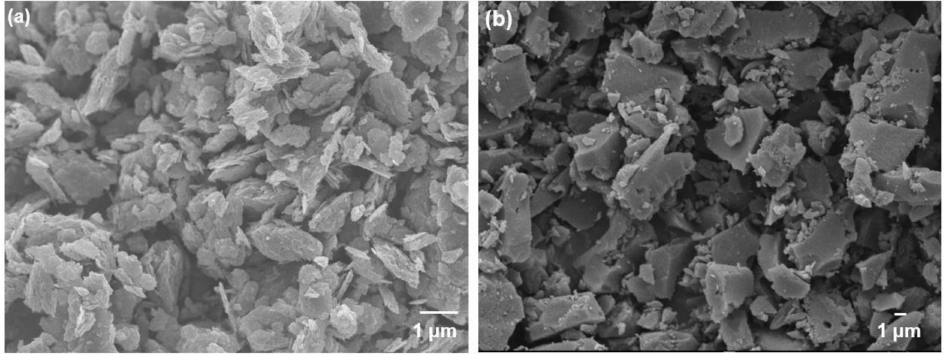
Figure 4. Field-emission scanning electron microscopy (FESEM) images of ( a ) GO and ( b ) YP-50F.